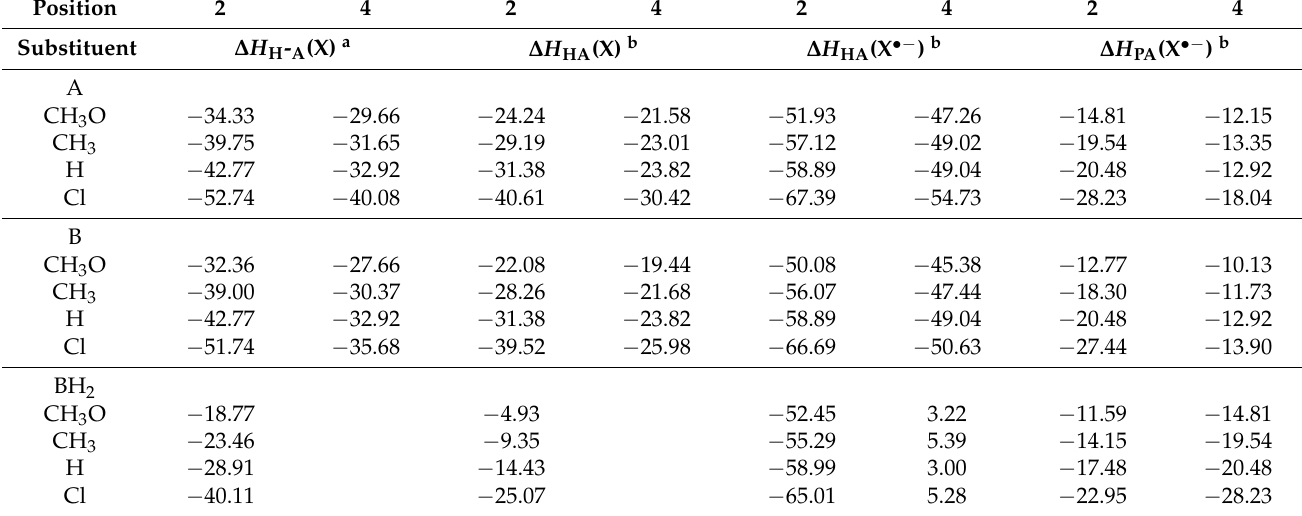
Table 2. Hydride and Hydrogen Affinities of Unsaturated Ketones (A, B) and Saturated Ketones (BH 2 ), Hydrogen and Proton Affinities of X • − in Acetonitrile.